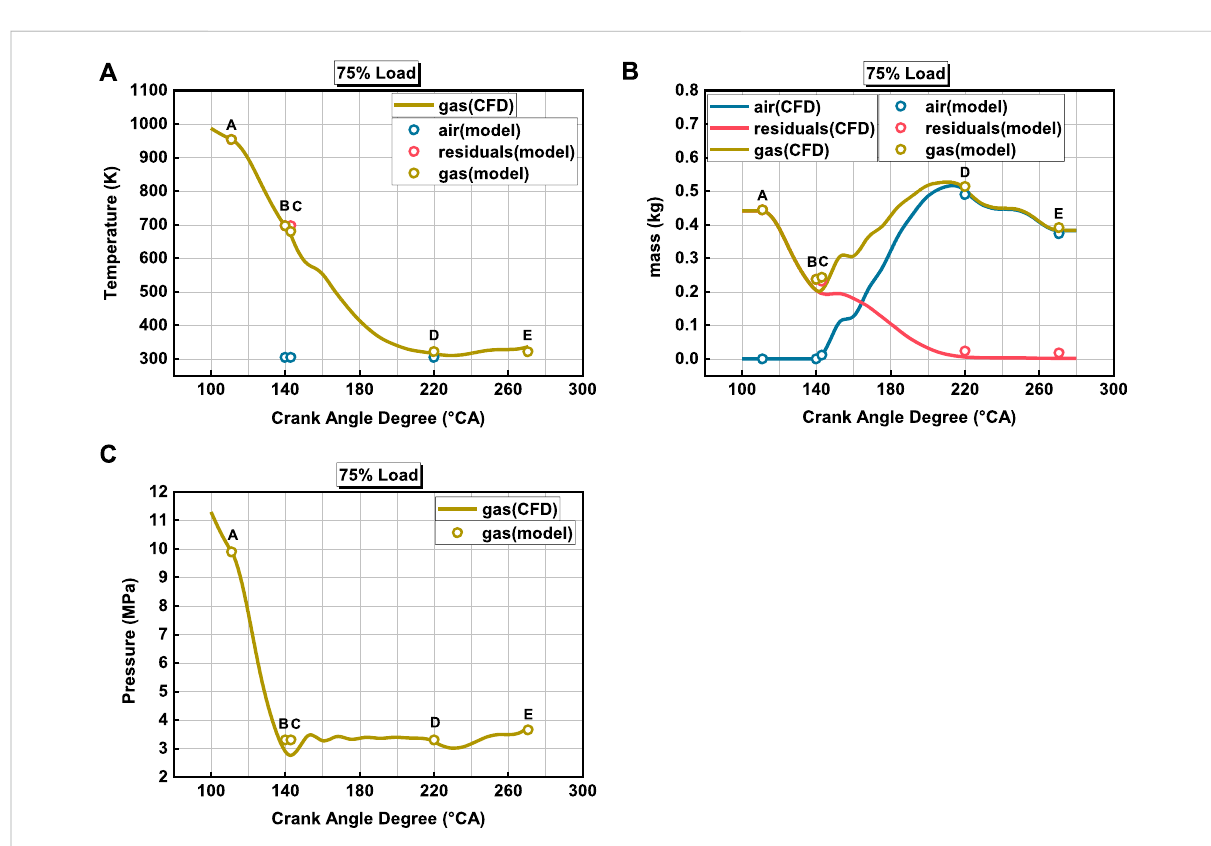
FIGURE 5 Evolution of (A) temperature, (B) mass and (C) pressure of each stage as predicted by the ZDMS model and the CFD model for the 75% load.